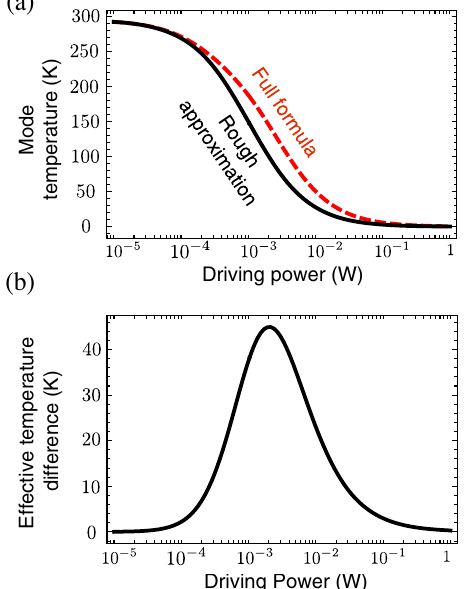
FIG. 10. Comparison between the full formula for the effective temperature Eq. (D12) and the approximate estimate Eq. (D18). (a) Effective temperature as given by Eq. (D12) (dashed line) and as given by Eq. (D18) (continuous line) as a function of the driving power. (b) Difference between the effective temperatures [Eq. (D12) − Eq. (D18)] as a function of the driving powers. For both plots we use the experimental parameters and driving scheme corresponding to the results of Fig. 6, and the bath 295 temperature is T bath ¼